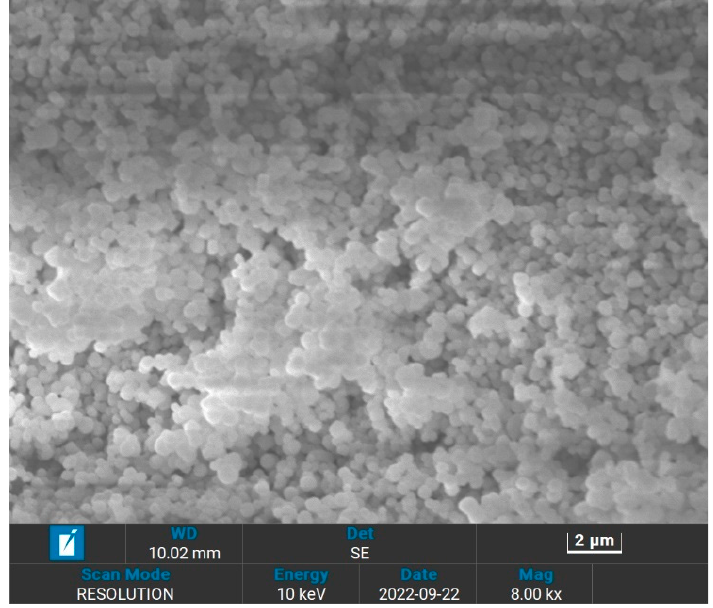
Figure 2. The surface of the pristine UiO-66 at 2 µm with magnification.